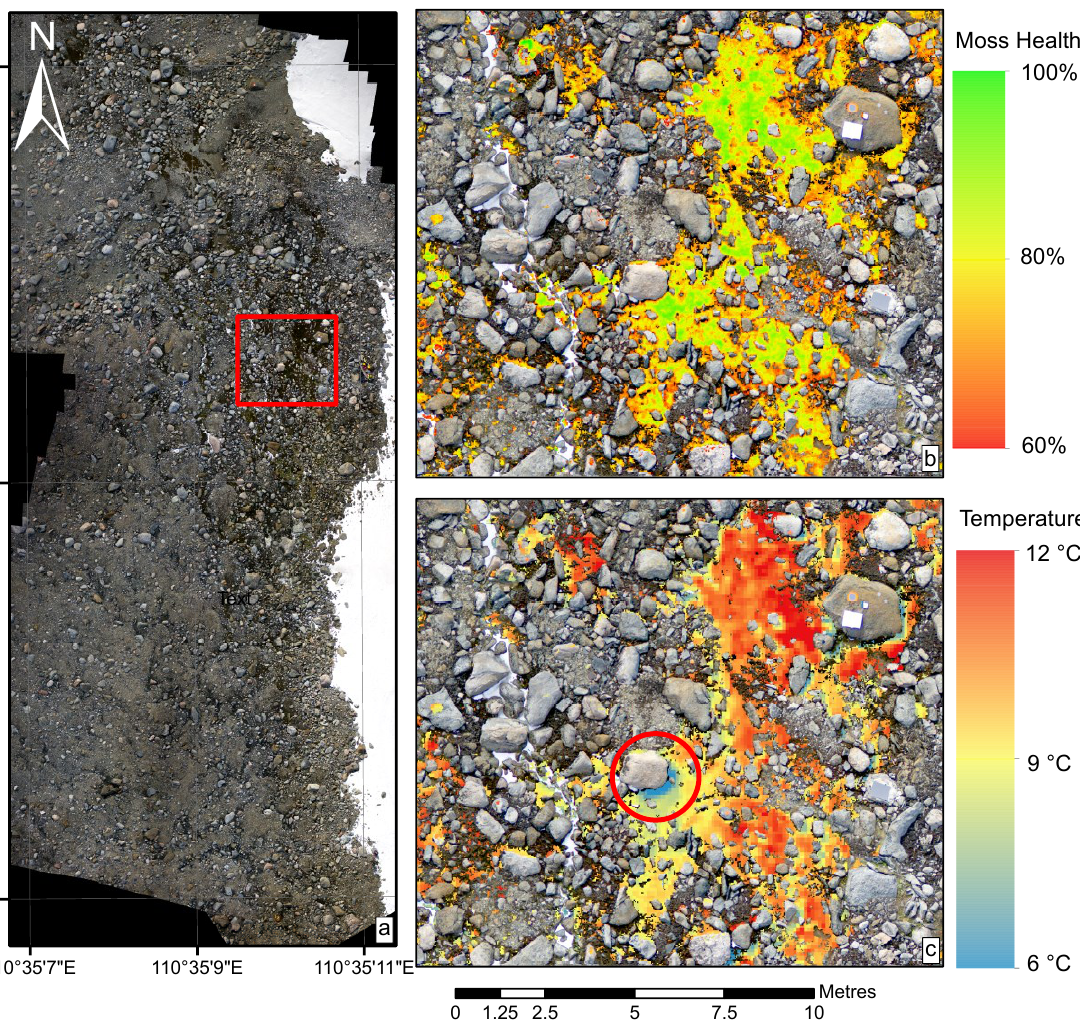
Figure 6. Spatially co-registered thematic maps; ( a ) Overview; ( b ) Moss health derived from MTVI2 vegetation index and ( c ) Moss surface temperature at ultra-high spatial resolution (a red circle highlights thermal shadow cast by tall